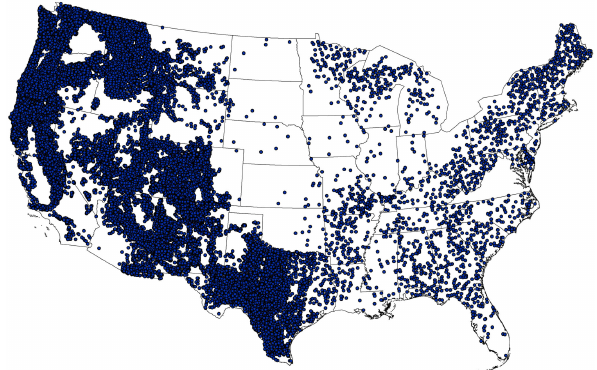
Figure 3. Location of FIA plots used to develop surface fuel load- ing